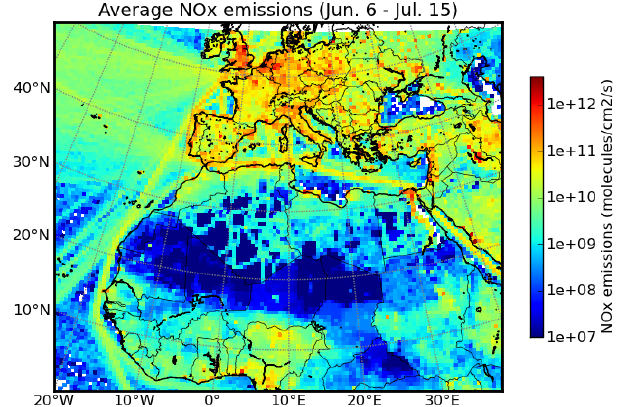
Figure 2. Mean NO x emissions from 6 June to 15 July, in moleculescm − 2 s − 1 as used for all three simulations.